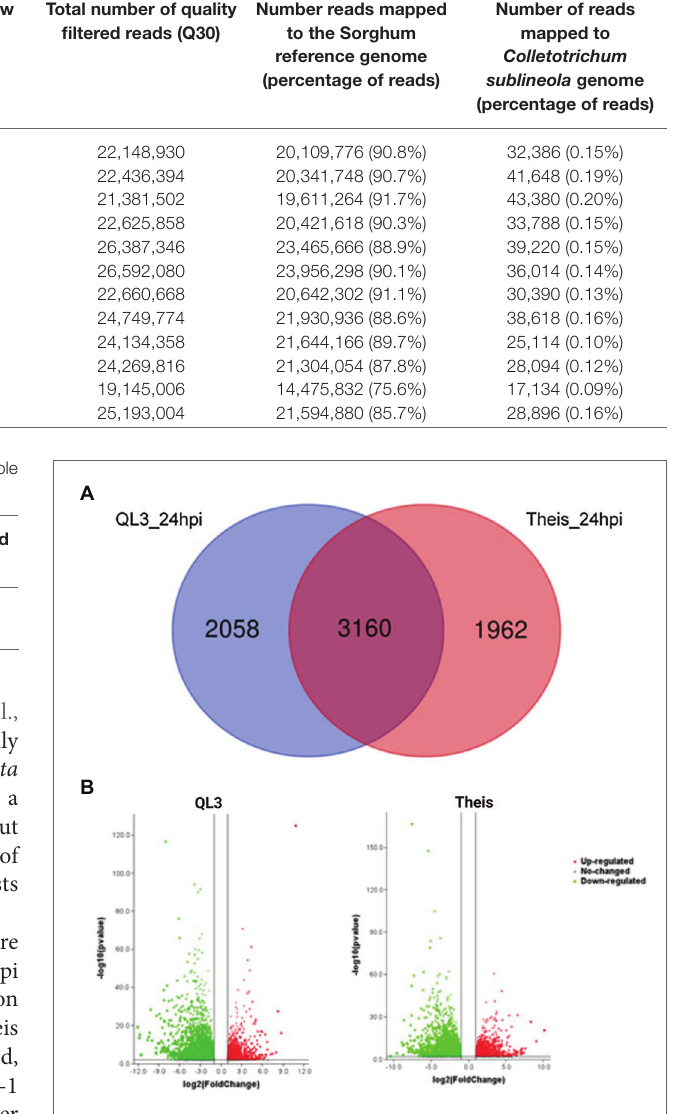
FIGURE 1 | (A) Venn diagram showing the number of differentially expressed genes (DEGs) among different pair-wise experimental combinations infected with Johnsongrass anthracnose. (B) Volcano plot showing the DEGs from QL3 and Theis. Green represents downregulated genes and red represents upregulated genes.